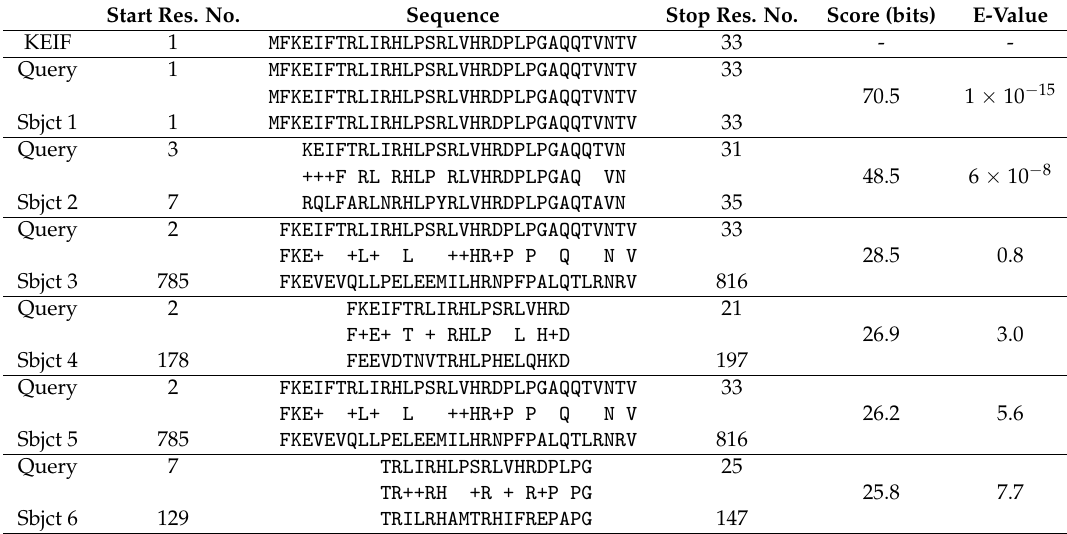
Table 1. Pairwise sequence alignment, score, and expect value for top six results obtained from amino acid sequence similarity search of